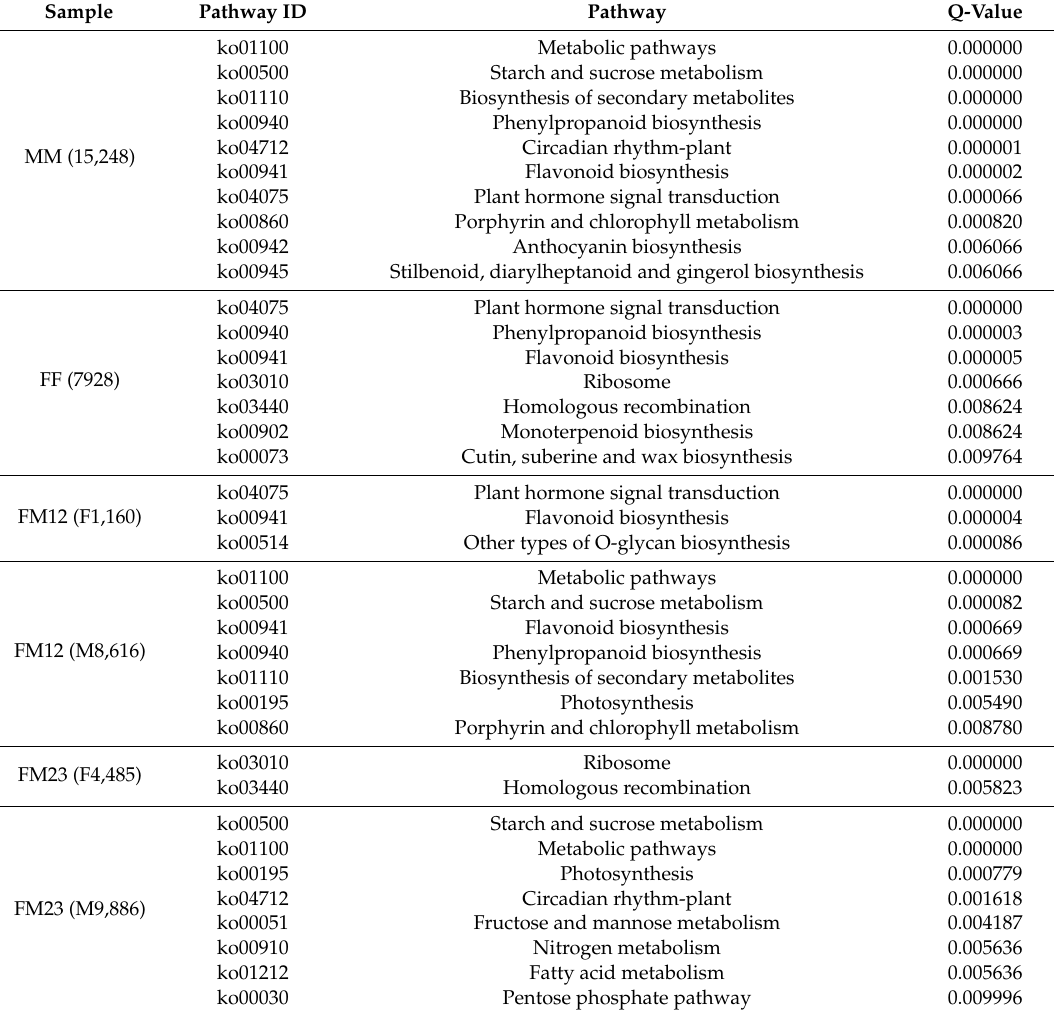
Table 2. The enrichment analysis on Kyoto Encyclopedia of Genes and Genomes (KEGG) pathway of DEGs among the three stages and the specific developmental stage (Q-value <